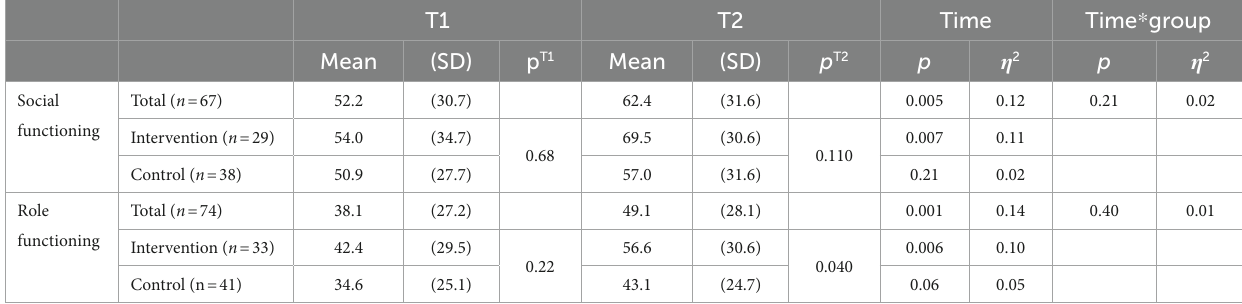
TABLE 3 Mean scores for social functioning and role functioning before and after intervention of the intervention group and in the control